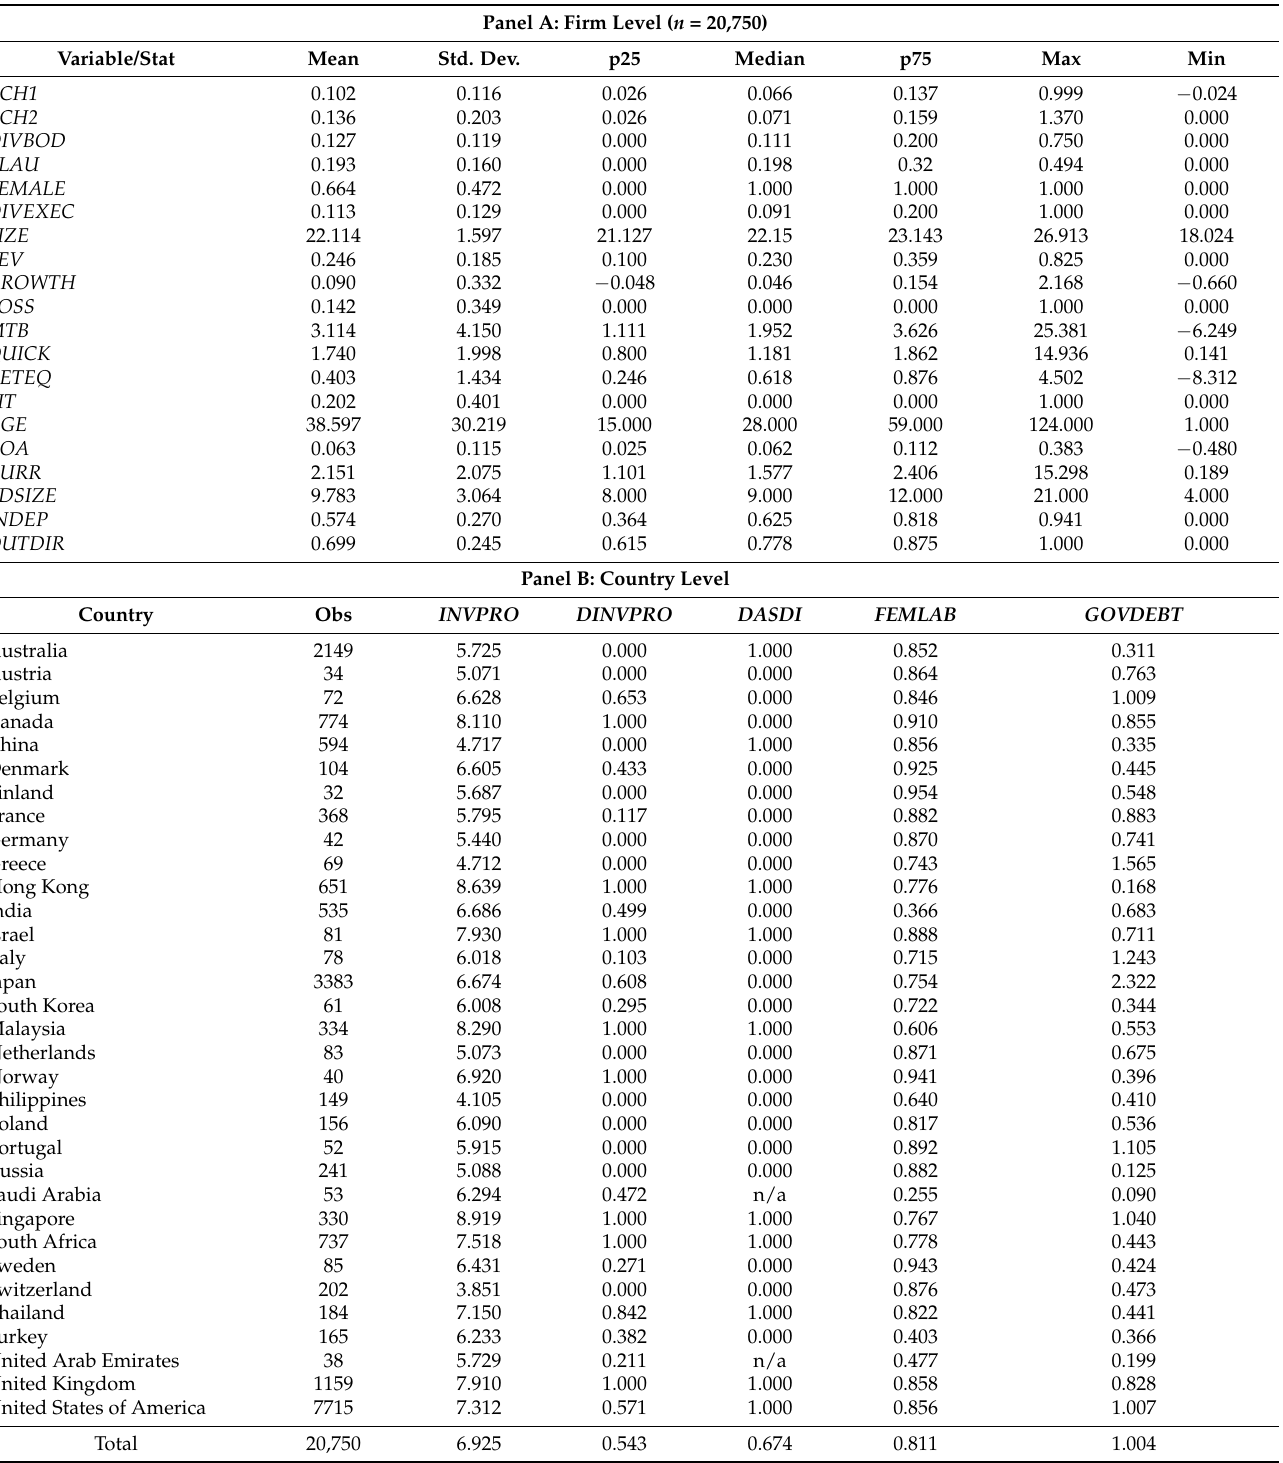
Table 1. Descriptive